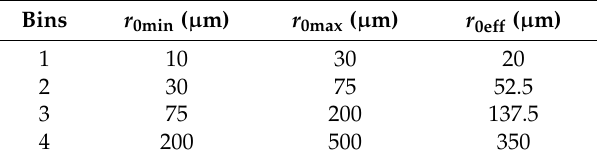
Table 2. Modified definition of the range size bins between r min and r max as used in this work (r min and r max represent the minimum and maximum droplet radii, r eff the effective radius).